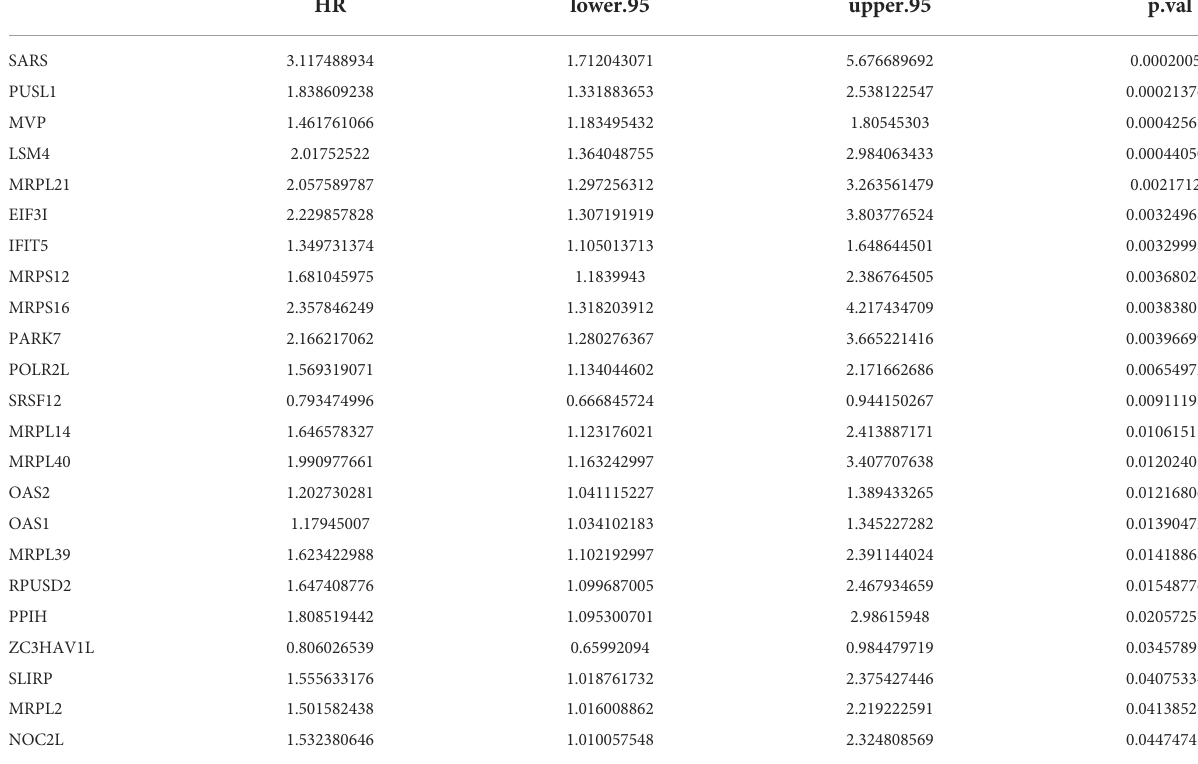
TABLE 1 Univariate Cox analysis to construction of the risk model. HR lower.95 upper.95